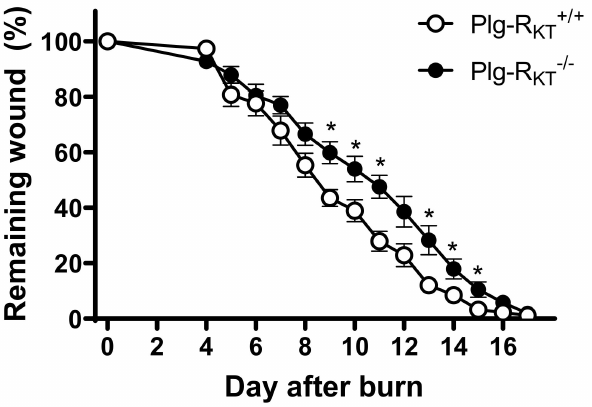
Figure 2. Effect of Plg-R KT deficiency on burn wound healing. (A) Quantification of the remaining wound area at different time points after wounding of male Plg-R KT − / − mice ( • ) and Plg-R KT+/+ litter mates ( ) ( n = 6). The mixed effects model (REML) showed a significant effect for time (cid:35) ( p < 0.0001, f = 396.6), and for genotype ( p = 0.040, f = 6.00), and a significant time X genotype interaction ( p < 0.0001, f = 4.289). Post hoc testing was done with 2-tailed t tests at each time point * p < 0.05. This figure is modified from a figure originally published in [80]. Creative common license available at: http://creativecommons.org/licenses/by/4.0/.